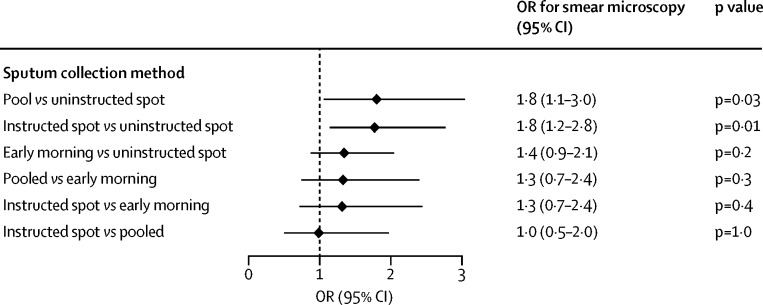
Forest plot of results of the network meta-analysisOR=odds ratio.